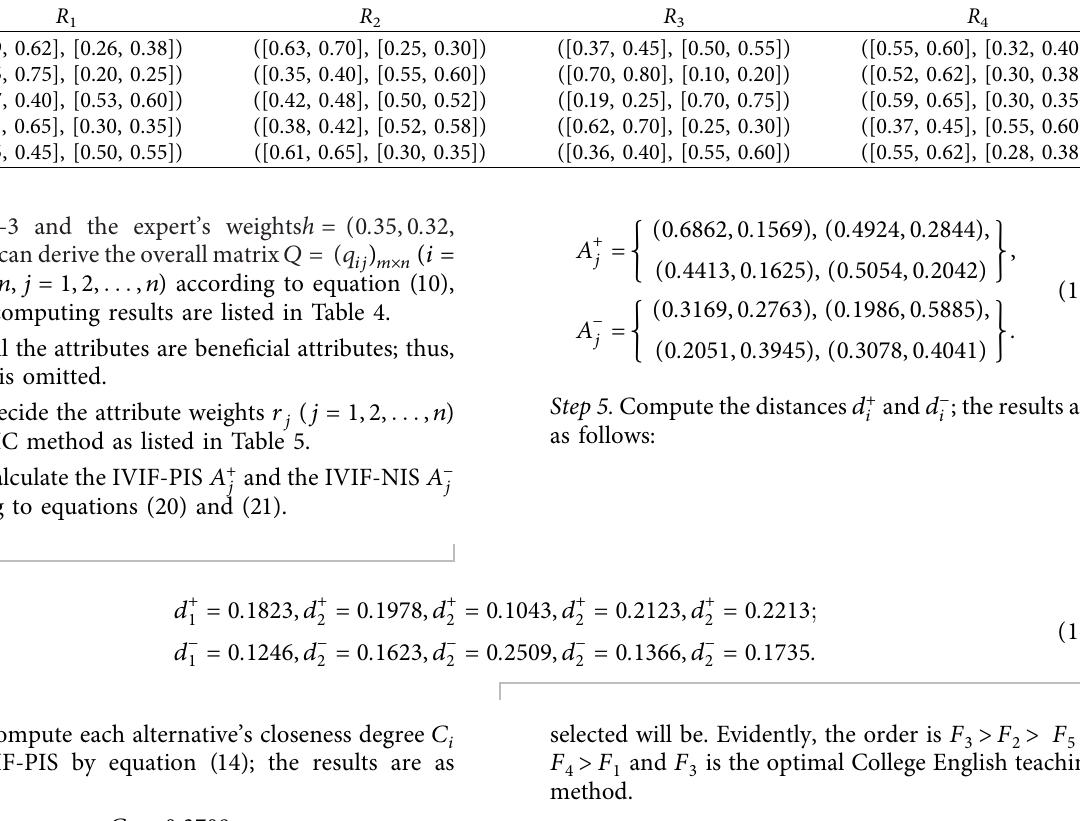
Table 2: Decision-making information given by H